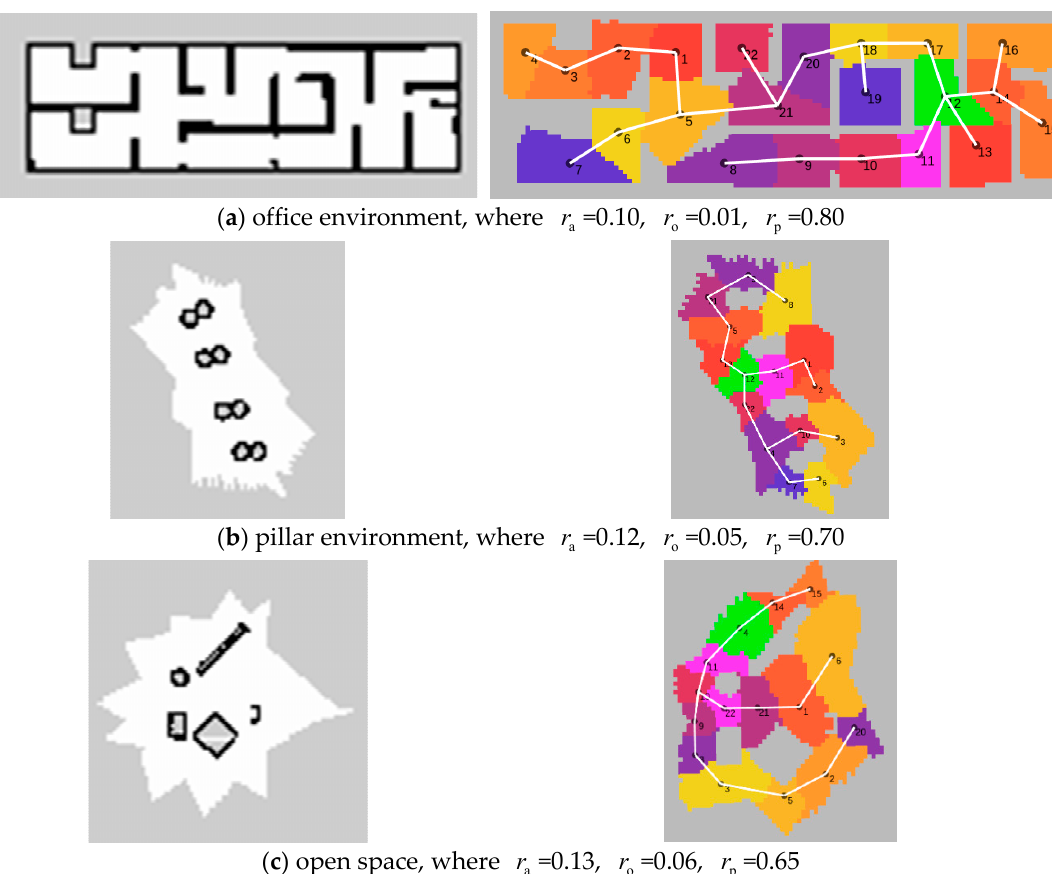
Figure 7. Occupied map ( left ) and its corresponding topological map ( right ).